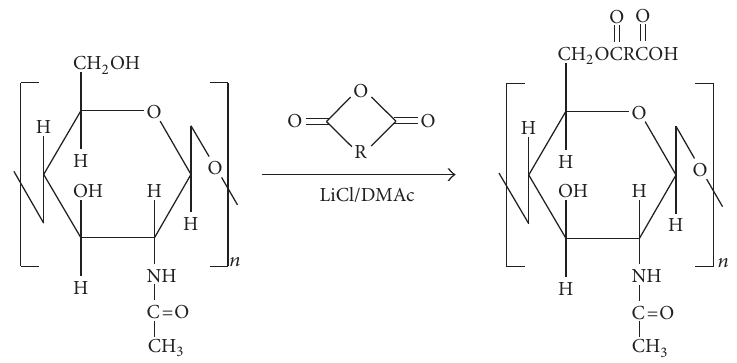
S 1: Route of the synthesis of chitin derivatives.